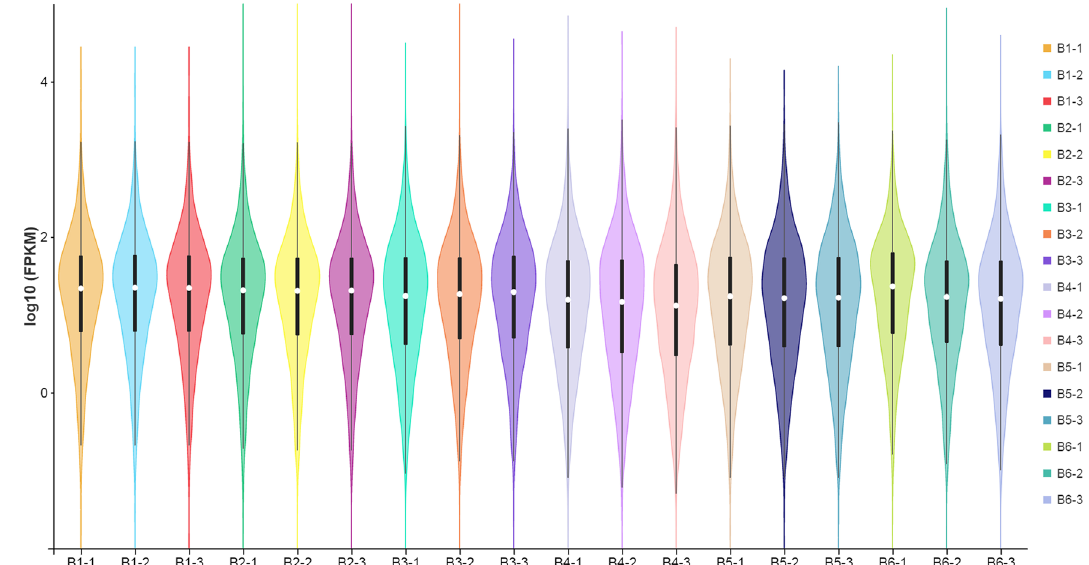
Figure 2. Violin map of horizontal distribution of gene expression (FPKM) in different samples. The abscissa is the name of the sample, and the ordinate is log10 (FPKM). The values from top to bottom represent the maximum, the upper quartile, the median, the lower quartile and the minimum in turn. The width of each violin represents the number of genes under the same